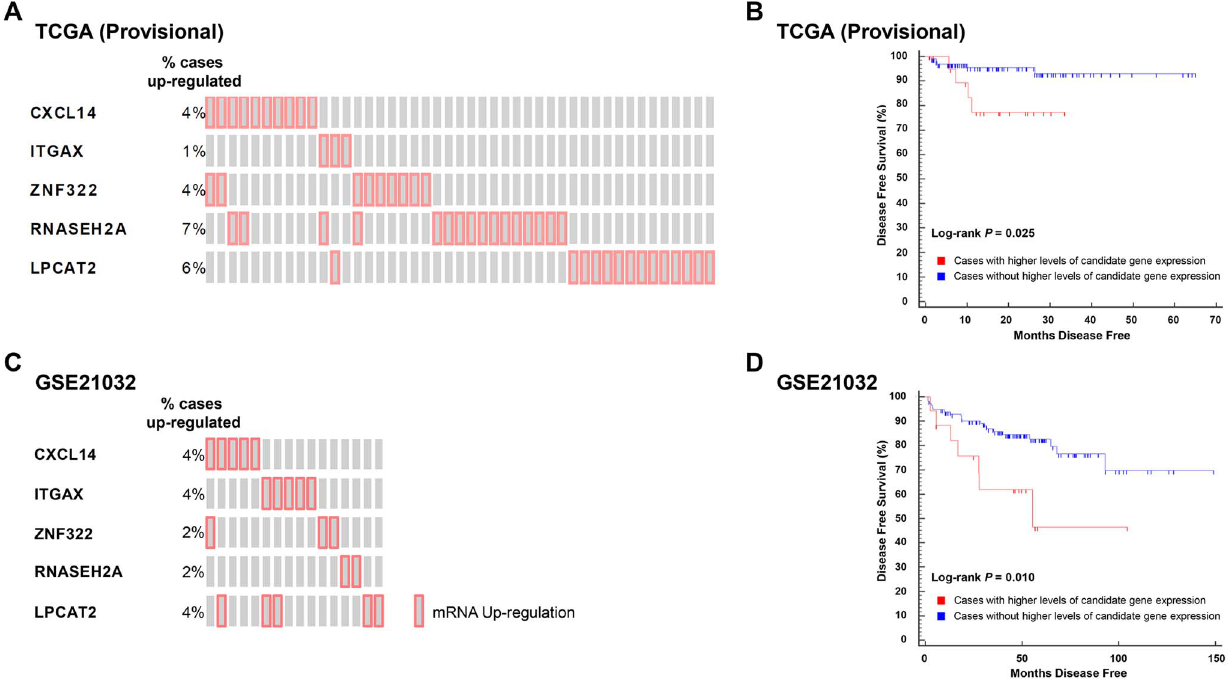
Figure 3. Higher levels of five QTL candidate genes are associated with poor DFS in TCGA (Provisional) and GSE21032 prostate cancer gene expression datasets. (A) ‘Oncoprint’ analysis demonstrates that 45/246 (18%) of cases in TCGA (Provisional) gene expression dataset have exclusively higher than average expression levels of five QTL candidate genes. (B) These higher levels of expression are associated with a reduced DFS in TCGA (Provisional) cohort. (C). Oncoprint’ analysis demonstrates that 16/131 (12%) of cases in the GSE21032 gene expression dataset have exclusively higher than average expression levels of the same five QTL candidate genes. (D) As was the case with TCGA (Provisional) dataset, higher levels of expression of these genes is associated with a reduced DFS in the GSE21032 cohort.